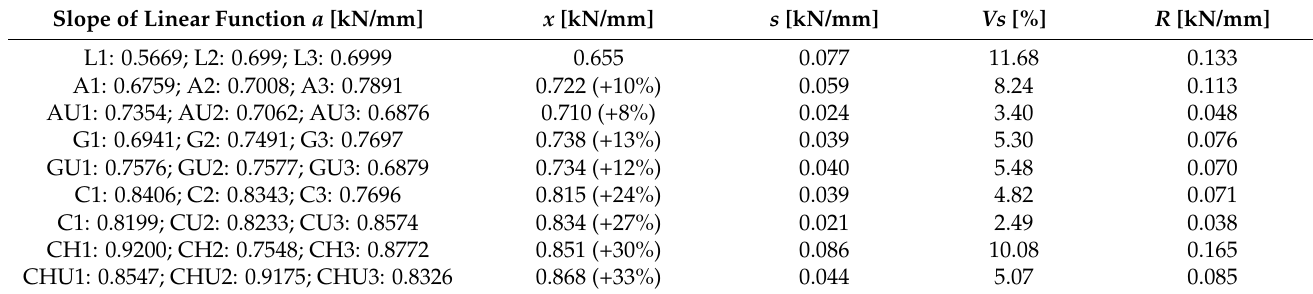
Table 5. Stiffness analysis.